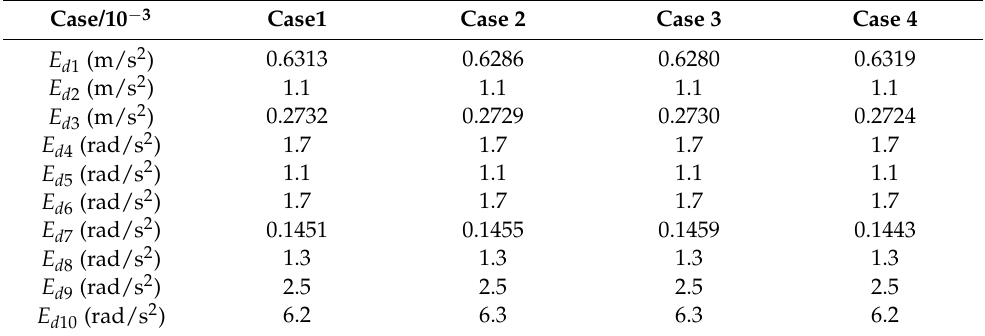
Table 7. Average estimation errors of the lumped disturbances under four cases from 10 s to 50